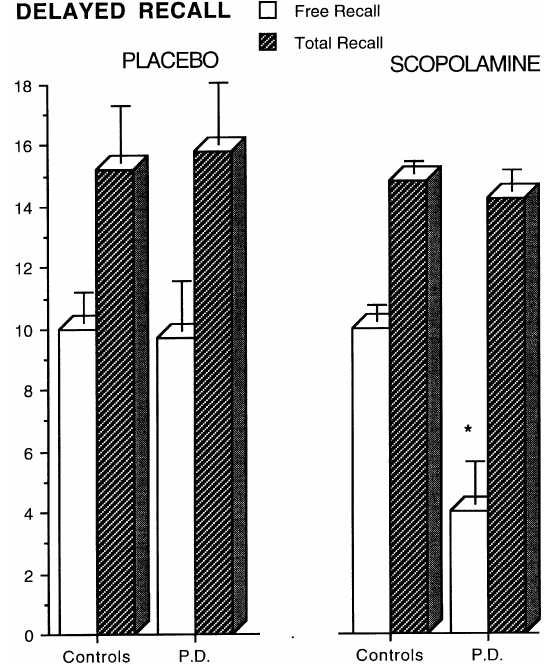
Fig. 2. Grober & Buschke verbal memory